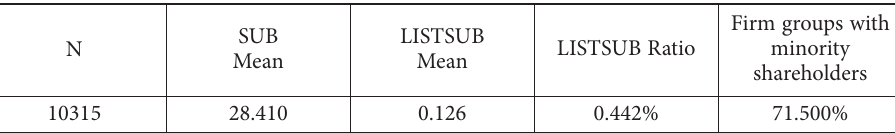
Firm groups with